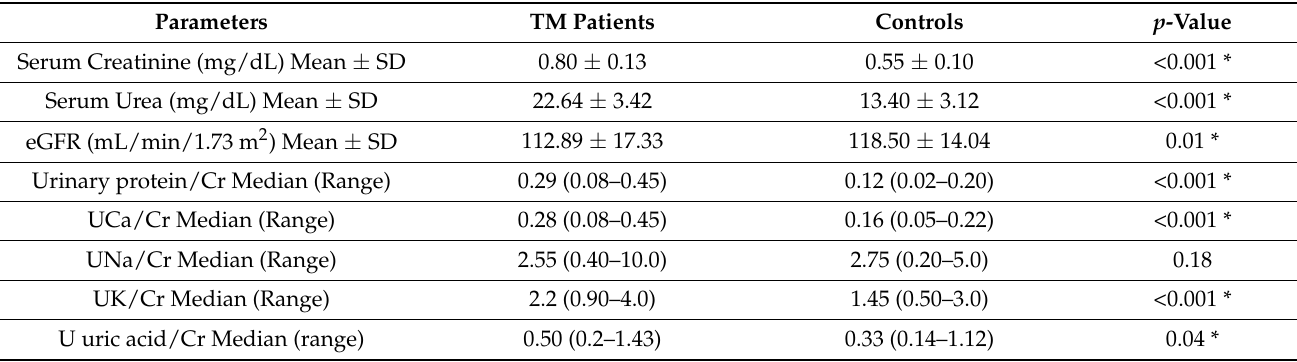
Table 2. Kidney function tests among studied groups.